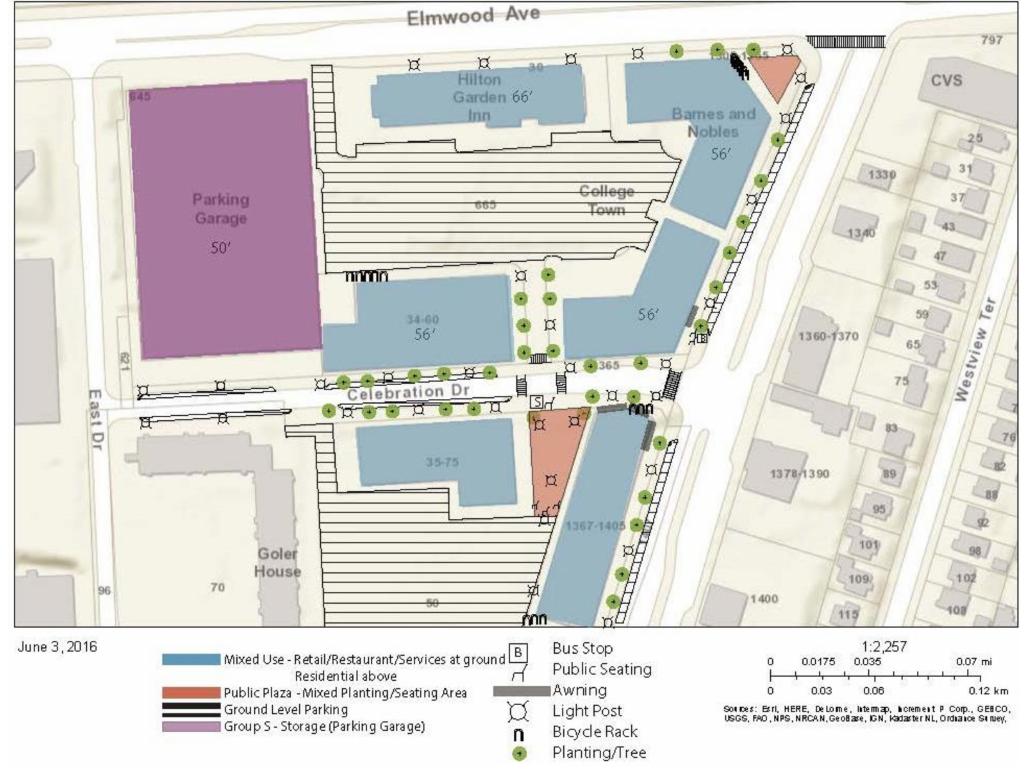
Figure 5. College Town urban form and pattern map (by